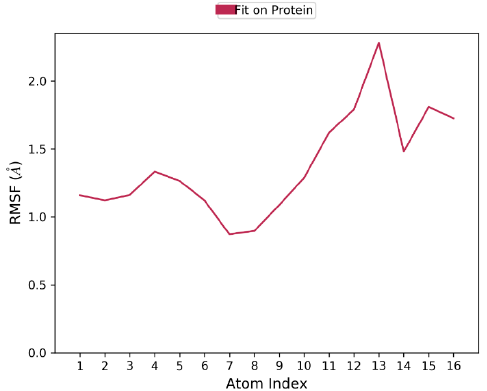
Figure 4. Ligand RMSF plot for characterizing changes in the ligand atom positions. The RMSF of all the atoms are not more than 2Å, which indicates that the binding is stable. The protein ligand interactions were monitored throughout the simulation, which is provided in Figure 5. The interaction fraction was calculated for each residue interacting with the ligand. The ‘interaction fraction’ is the number of times each residue of PvdA interacts with the ligand. The interactions are normalized over the course of the simulation, 100 ns being 100%. For example, a value of 0.6 indicates that for 60% of the total simulation time, the particular residue was interacting with the ligand. Values above 1.0 are possible, as some of the residues have more than one interaction with the ligand. ARG357 was found to be the key residue of interaction, as it has three interactions, namely H-bonding, and ionic and water-bridge with the atoms of N-2-succinyl-ornithine (Figures 2b, 5, S3 and S7). The number of times the ligand contacts the protein through the 100 ns simulation is also shown in Figures 6, S4 and S8. This contact diagram strengthens our finding that Arg357 is important for binding, as it makes more than one contact with the ligand.